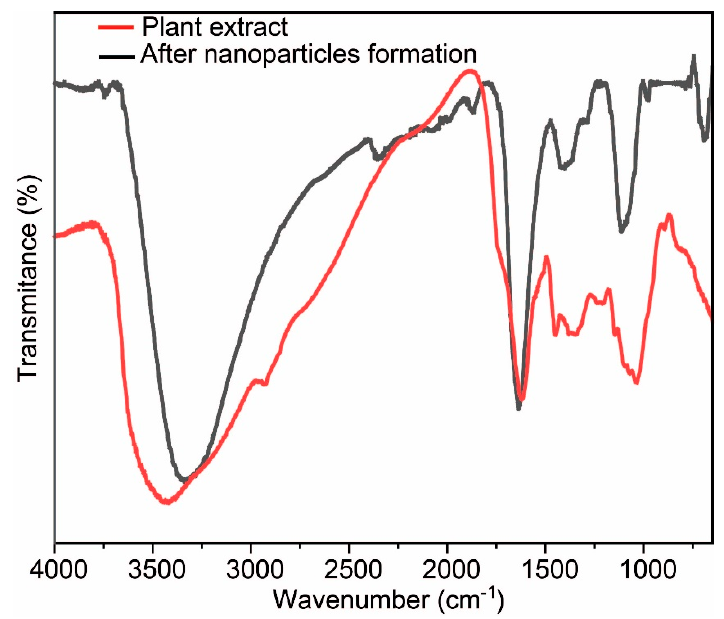
Figure 3. FTIR spectrum of B. ramiflora leaves extract and synthesized Fe 3 O 4 NPs.